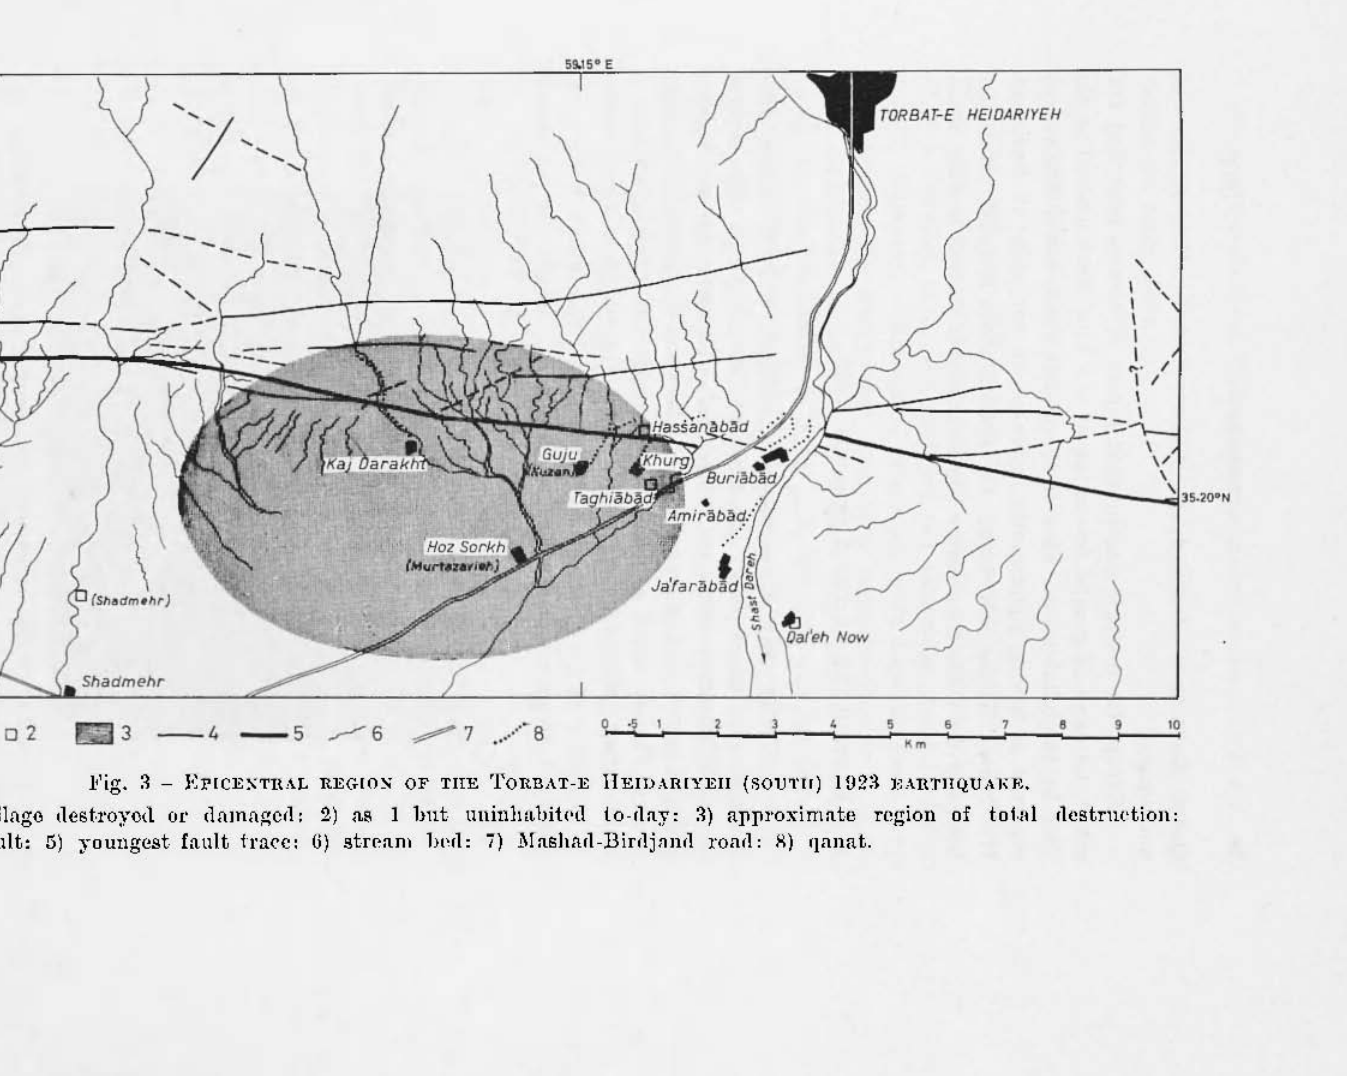
Fig. ::I - El'ICE!'Tl\,\L REGIO", OF TIIE 'l'ORBAT-E lIEJl)ARIYEII (~OUTtr) IDZ::!